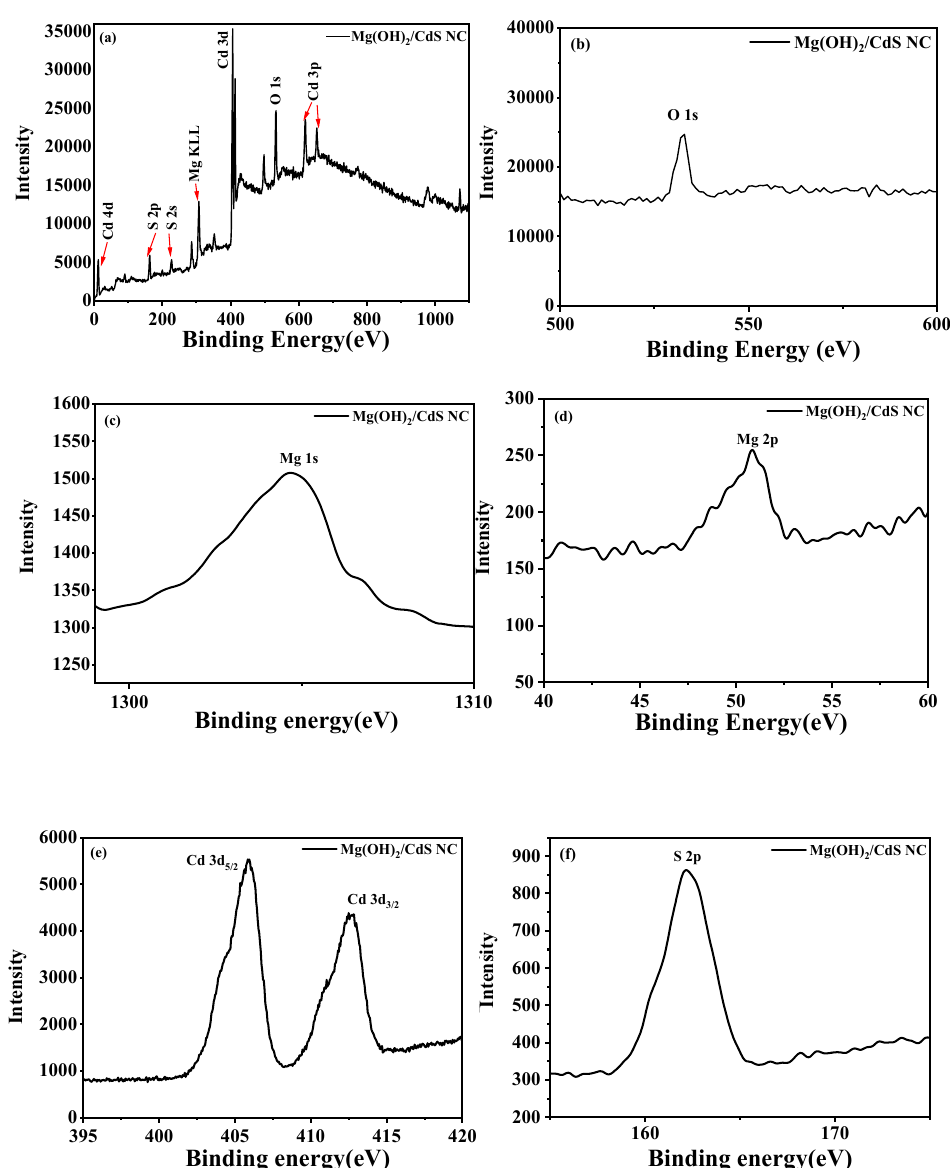
Fig. 4. XPS of Mg(OH) /CdS hetero nanostructures showing chemical composition and oxidation state of the synthesized material (a) 2 Combined Binding energy peaks of Mg KLL, S 2s and 2p, Cd 3d and 3p, O 1s (b) Binding energy of O 1s (c)and (d) Binding energy of Mg 1s and 2p respectively (e) Binding energy of Cd 3d (f) Binding energy of S